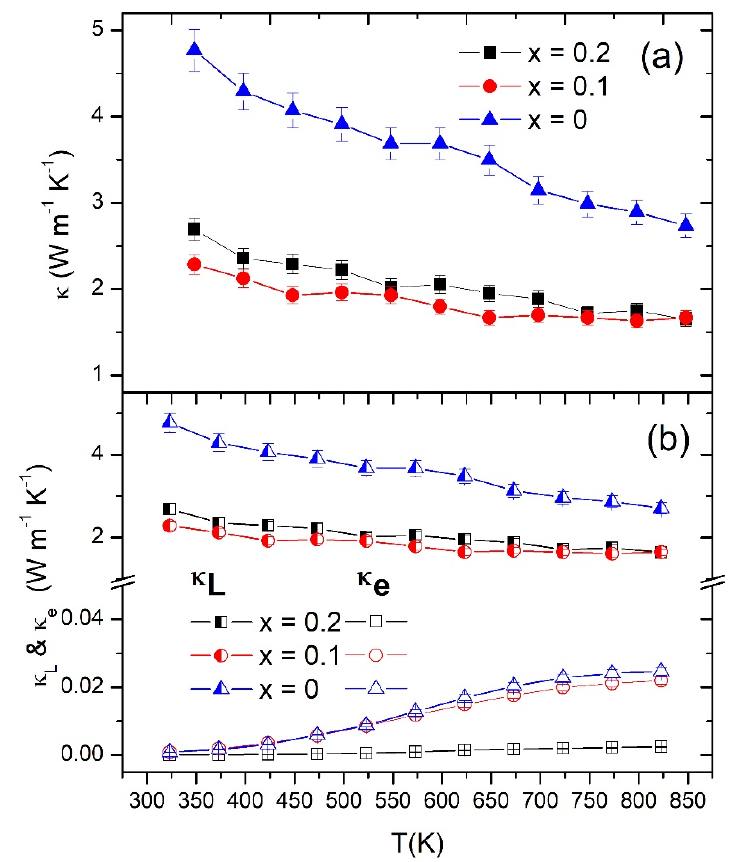
Figure 6. Temperature dependence of the ( a ) total thermal conductivity and ( b ) electronic ( κ e ) and lattice ( κ L ) contributions of Sr 1-x Ti 0.9 Nb 0.1 O 3 − δ (x = 0, 0.1, 0.2).